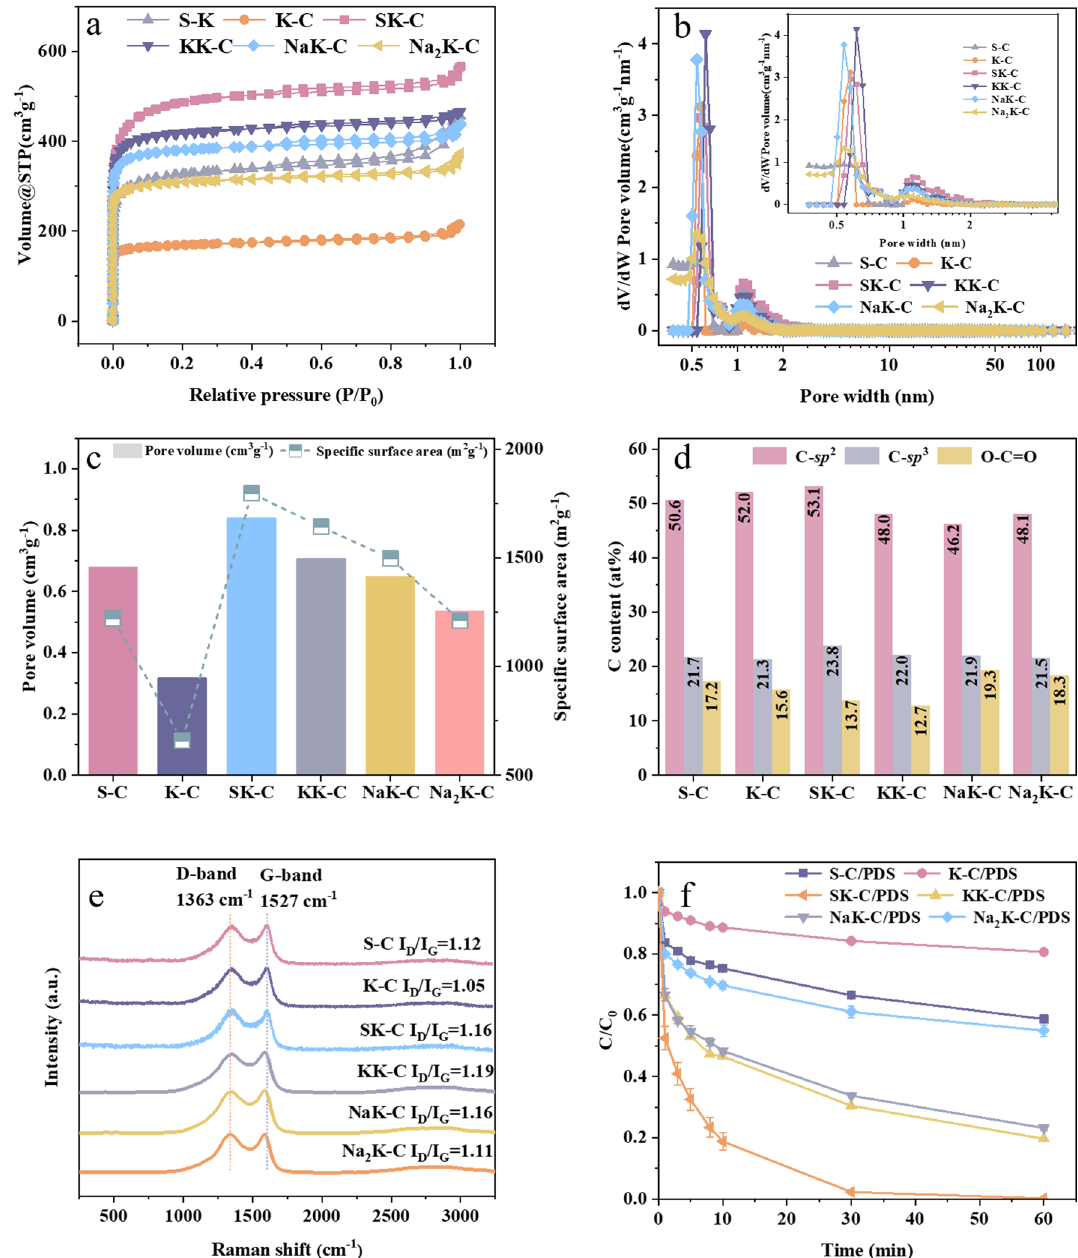
Fig. 2 N 2 adsorption–desorption isotherms ( a ), pore size distributions ( b ), and the values of specific surface area and pore volume ( c ) of prepared catalysts. The C content (at%) of different catalysts based on XPS spectra ( d ) and Raman spectra ( e ). The removal ( f ) efficiency of SDZ in various reaction systems. Experimental conditions: [PDS] 0